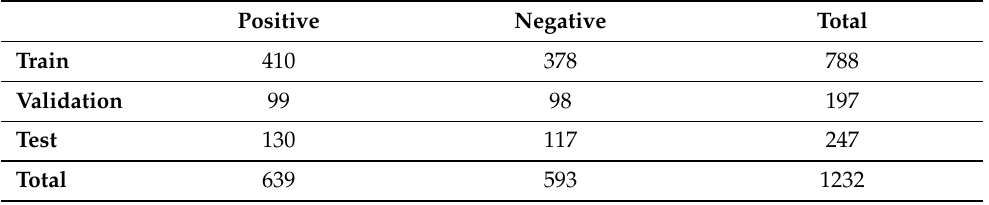
Table 1. The distribution of sentiment labels across the three datasets. Positive Negative Total Train 410 378 788 Validation 99 98 197 Test 130 117 247 Total 639 593